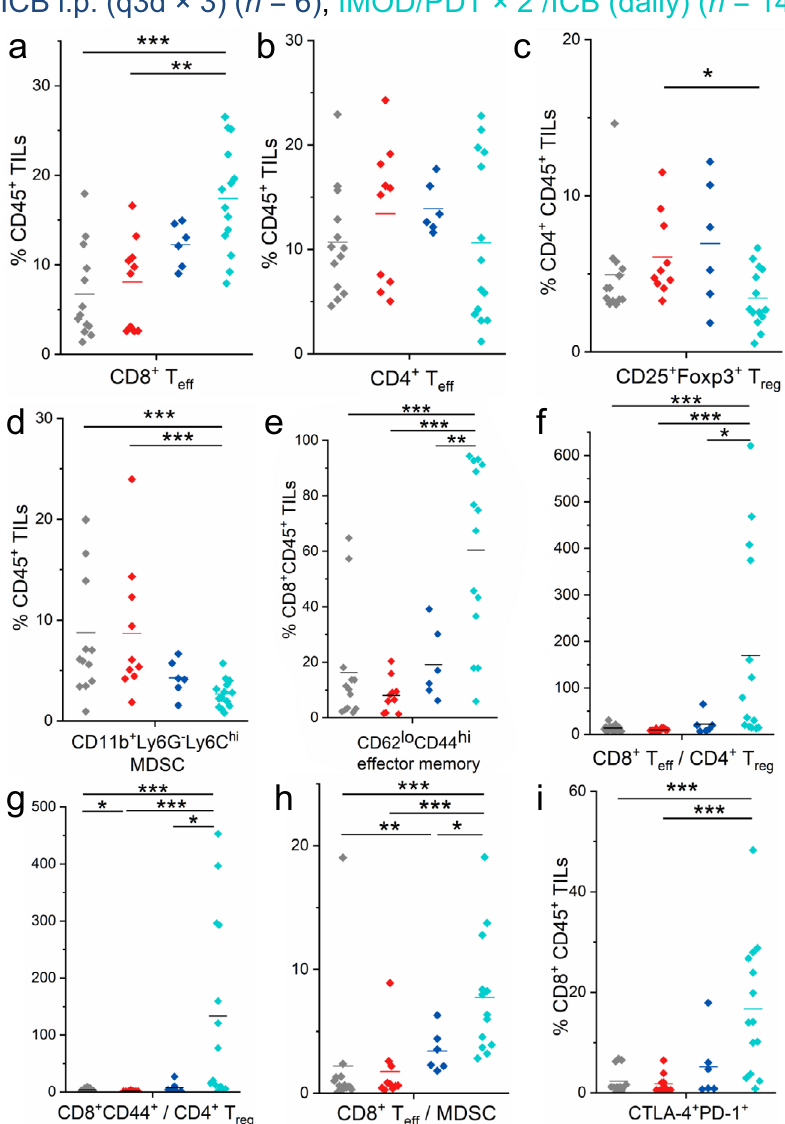
Fig. 6 Effects of delivering a combination of PDT and ICB antibodies via IMOD on TILs in E0771 tumors. The panels show data for E0771 tumors ( n = 6 – 14) in C57BL/6 mice that were untreated or were treated with PDT (q3d × 2) via an implanted IMOD, or ICB antibodies (i.p. q3d × 3), or PDT (q3d × 2) and ICB antibodies (daily) via IMOD (referred to as IMOD/PDT × 2/ICB (daily)). Tumors were collected on day 9 or 10 after the start of treatment and were analyzed by fl ow cytometry (for mice receiving combination regimen, the collection of tumor started on day 8 while tumor sizes were ~100 mm 3 ). a Frequencies of CD8 + CD3 + effector T (T eff ) cells in TILs. b Frequencies of CD4 + CD3 + T eff cells in TILs. c Frequencies of CD25 + Foxp3 + regulatory T (T reg ) cells in CD4 + TILs. d Frequencies of CD11b + Ly6G − Ly6C hi myeloid-derived suppressor cells (MDSCs) in TILs. e Frequencies of CD44 hi CD62L lo effector memory cells in CD8 + TILs. f Ratio of CD8 + T eff cells to CD4 + CD25 + Foxp3 + T reg cells. g Ratio of CD8 + CD44 + T cells to CD4 + CD25 + Foxp3 + T reg cells. h Ratio of CD8 + T eff cells to MDSCs. i Frequencies of CTLA-4 + PD-1 + cells in CD8 + TILs. Statistical signi fi cance is determined by Mann – Whitney U -tests. * P < 0.05, ** P < 0.01, *** P < 0.001. Source data and P values are provided in the Source data fi